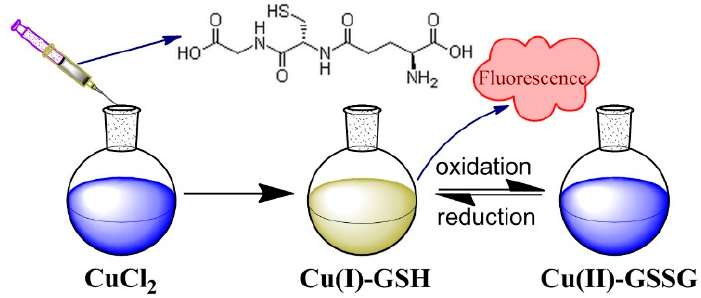
Figure 1. Schematic illustration for the preparation of Cu(I)-GSH and Cu(II)-GSSG complexes.